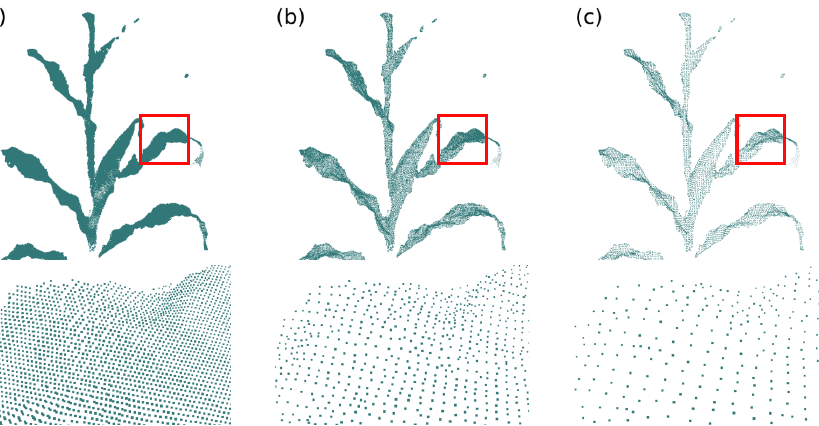
Figure 6. Point cloud standardization. ( a ) Input point cloud; ( b ) point cloud with 3mm resolution and ( c ) point cloud with 5mm